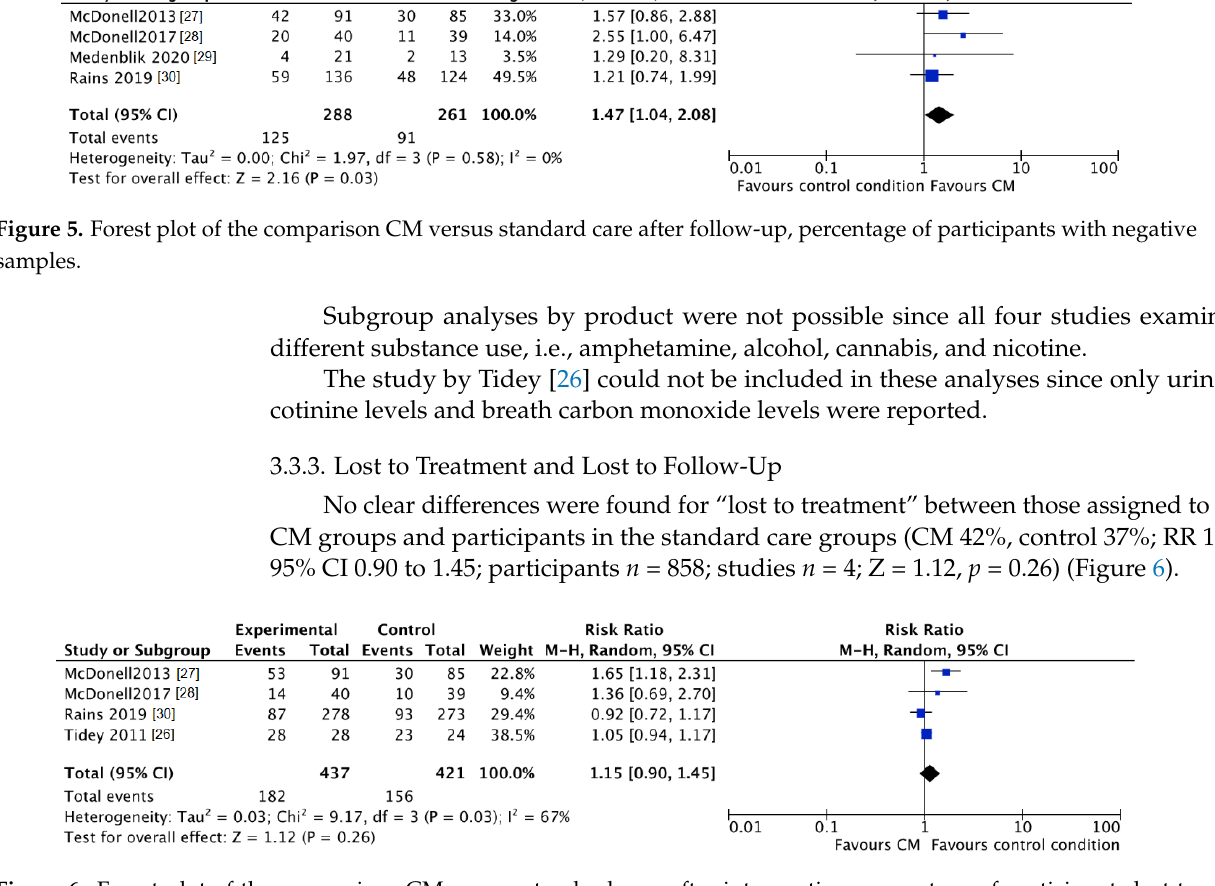
Figure 6. Forest plot of the comparison CM versus standard care after intervention, percentage of participants lost to treatment.